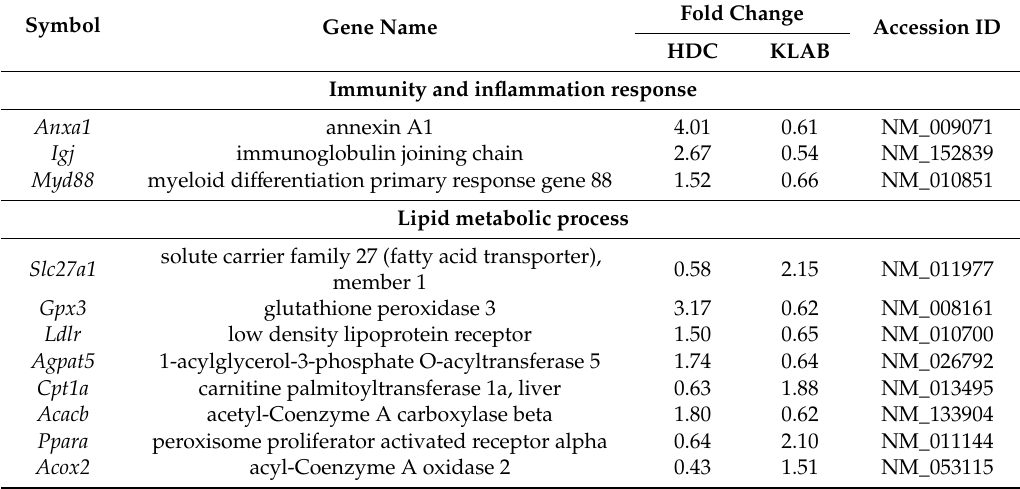
Figure 4. Hierarchical clustering of differentially expressed genes in the liver of L. brevis OPK-3 treated mice. A total of 591 deregulated genes were analyzed based on statistical significance as described in the Methods section. The heat map is represented with the expression value of each individual array. Table 3. Comparison of gene expression between high-fat diet and L. brevis OPK-3.